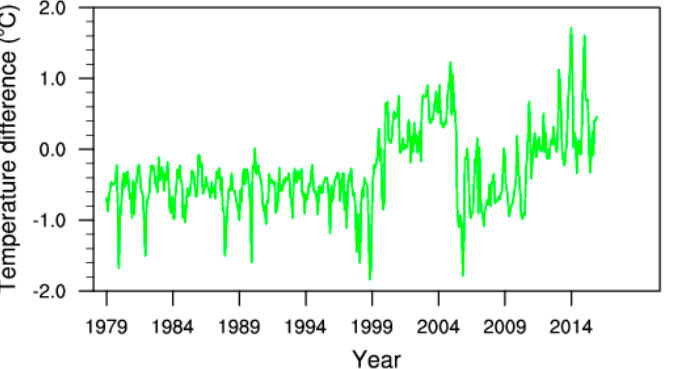
Figure 2. Monthly air temperature difference between ITPCAS and observations at the Maduo station